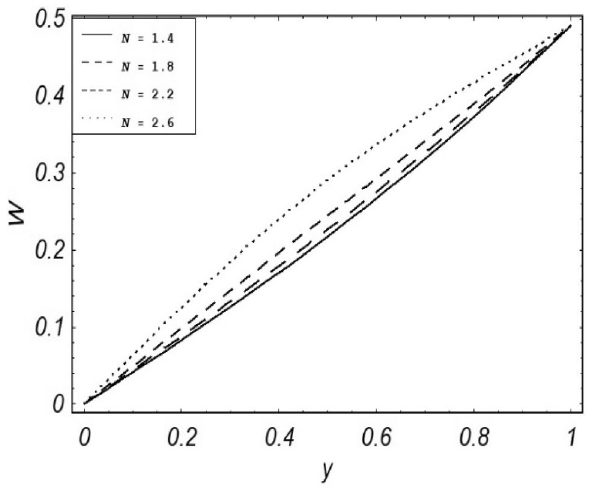
Figure 9. Evolution of W with various values of N if t = 1 ; Gr = 0.7 ; K = 0.5 ; η = 2 ; � = 0.5 ; Re = 1 ; α = 0.1 ; ω = 0.5 ; ε = 0.001 ; m = 0.5 .